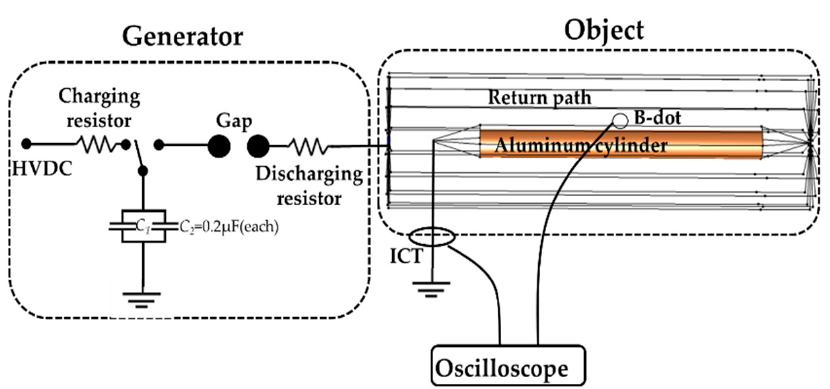
Figure 5. The B-dot calibration environment. The calibration system consists of a generator and object. The generator is connected in parallel by two capacitors with a capacitance value of 0.2 µ F, and the high-voltage DC power charges the capacitors through a charging resistor. The coaxial loop generates a uniform magnetic field. The B-dot is placed in the middle of the aluminum barrel. A current sensor is used to collect the output